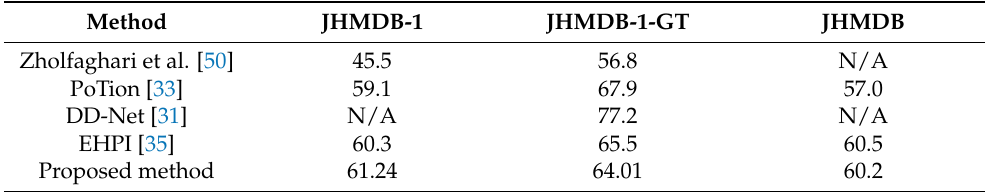
Table 4. Results (accuracy, %) on JHMDB compared with other skeleton-based